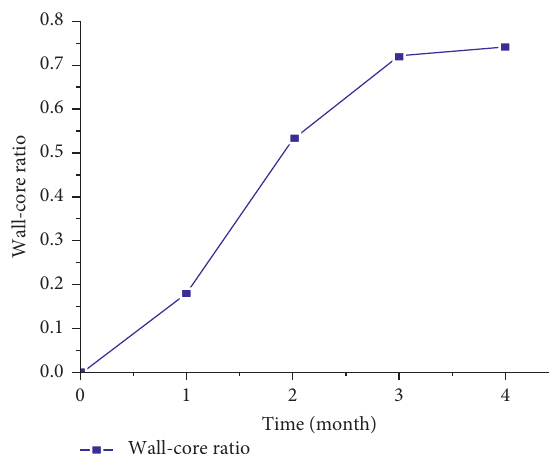
Figure 9: The trend of wall thickness with respect to various wall-core ratios.